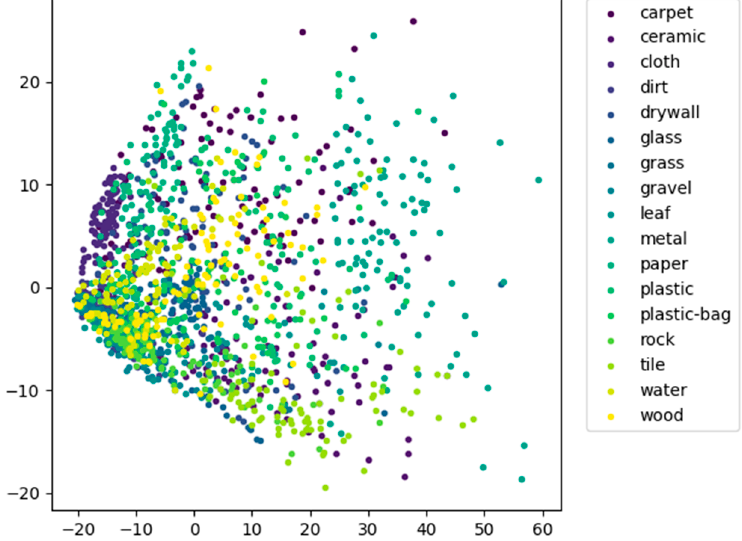
Figure 12. Data distribution of 17 material classes.